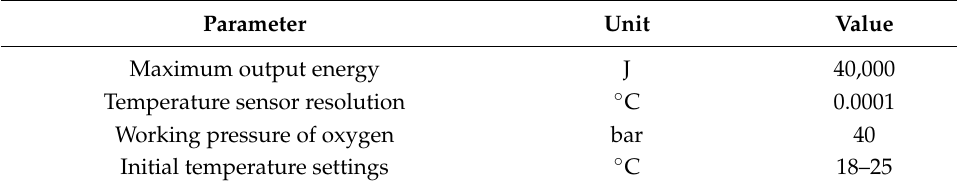
Table 2. Technical specification of IKA C 200 calorimeter.